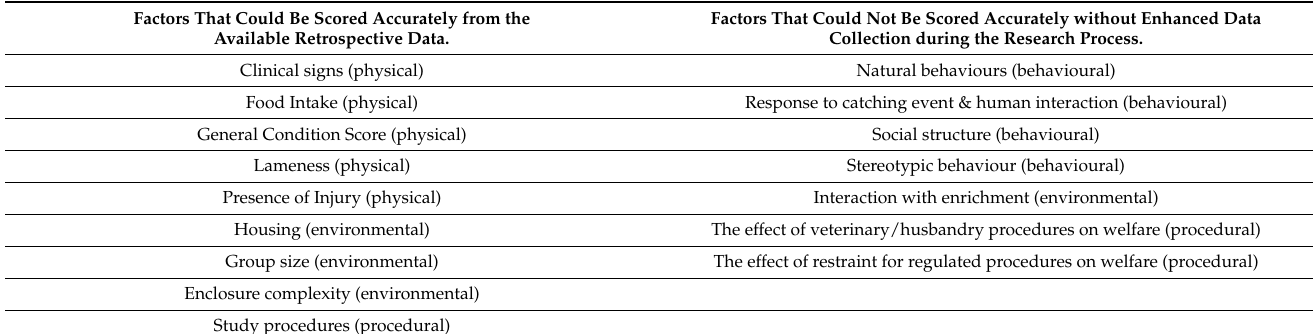
Table 2. Table showing all factors scored in cattle and pigs, separated into those that could be scored accurately using the available data, and those that could not be. The parameter each factor belongs to is shown in parenthesis. Factors That Could Be Scored Accurately from the Available Retrospective